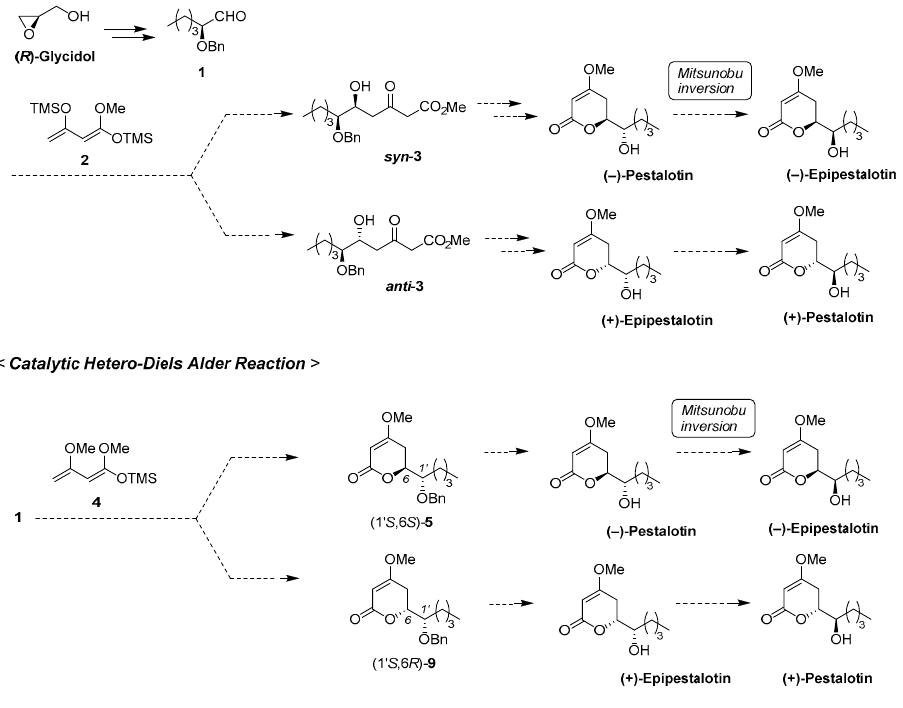
Scheme 1. Strategies for asymmetric total syntheses of pestalotin